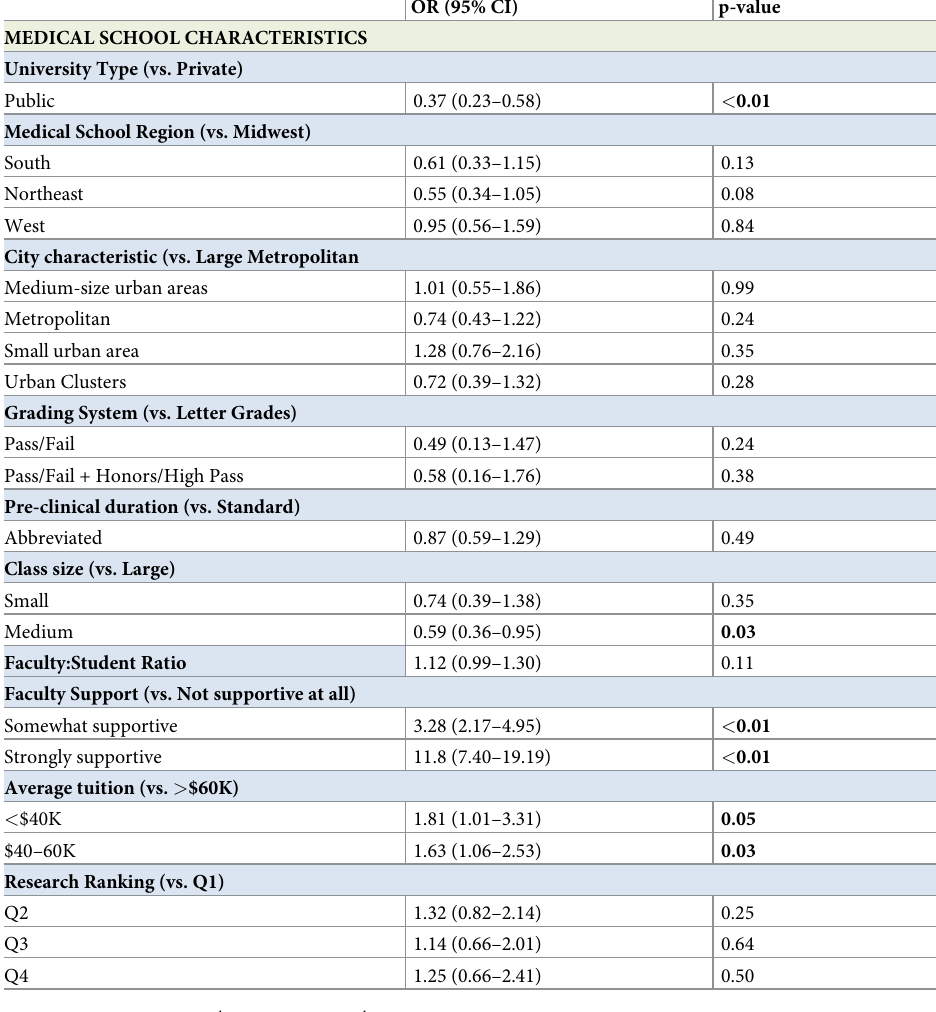
Table 3. Medical school predictors of high ( � 3) wellbeing resource